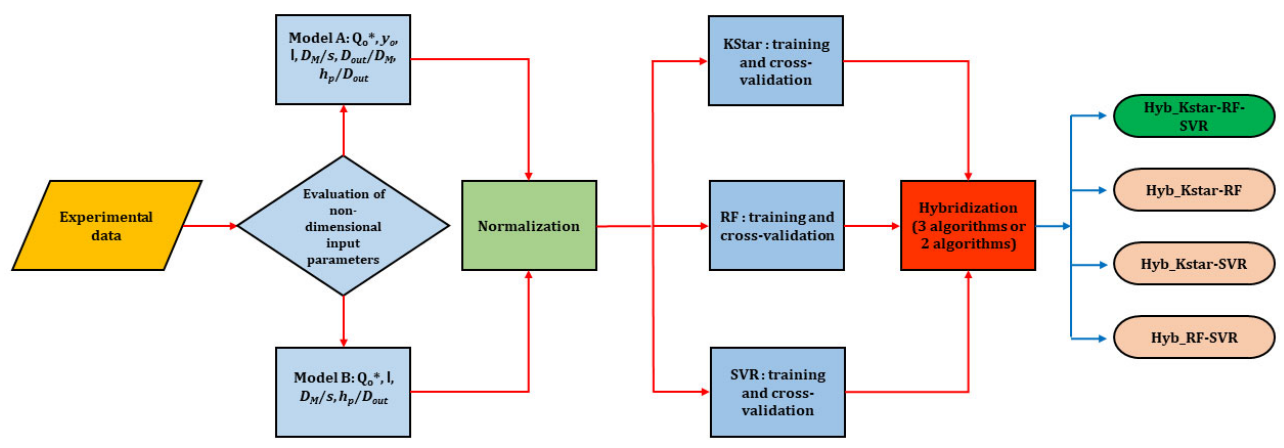
Figure 4. Flowchart of the model development procedure.